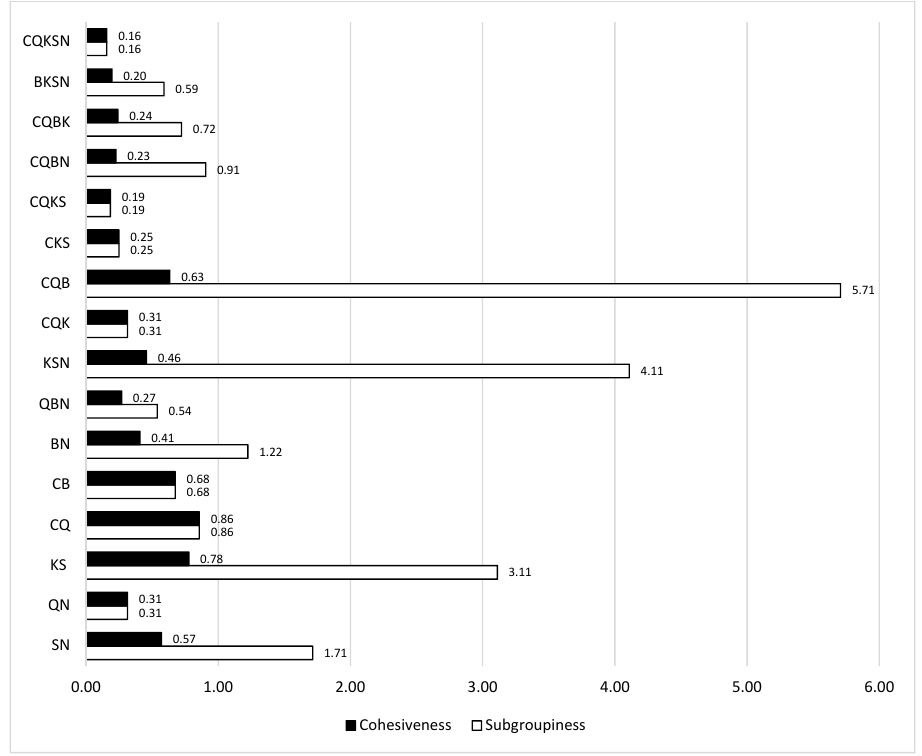
Figure 1. Historical Glottometry Scores of Attested Egypto-Sudanic Dialect Subgroupings.